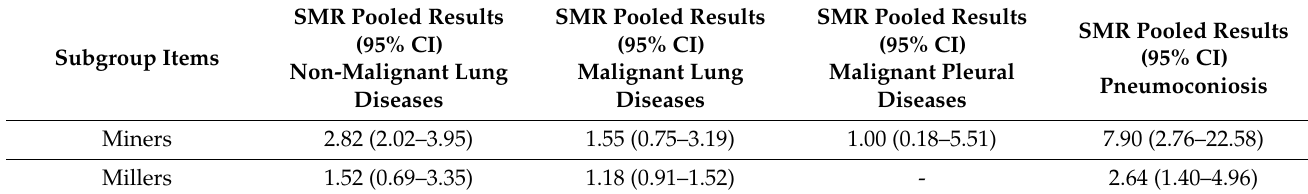
Table 5. SMR pooled results for all respiratory diseases for miners and millers